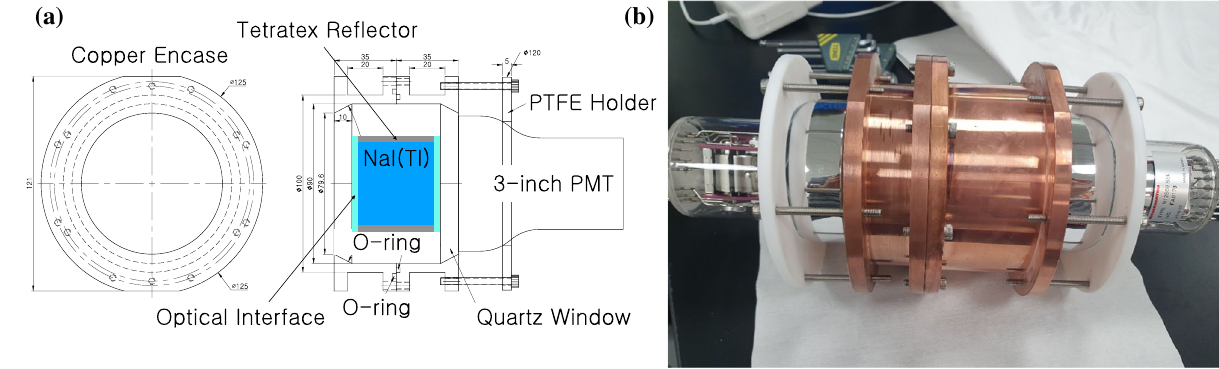
Fig. 5 NaI-035 detector. The diagram a shows the encapsulation design and the photo b shows the final